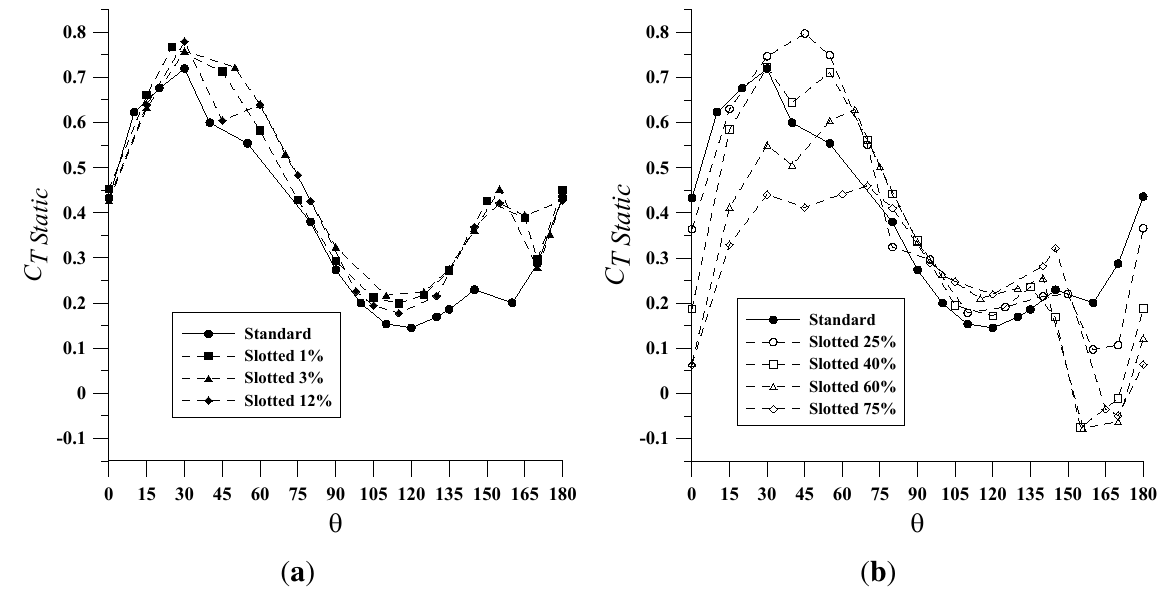
Figure 7. Torque static coefficients for standard ( a ) f = 1% , f = 3% and f = 12% ; and for ( b ) f = 25% , f = 40% , f = 60% and f = 75% .